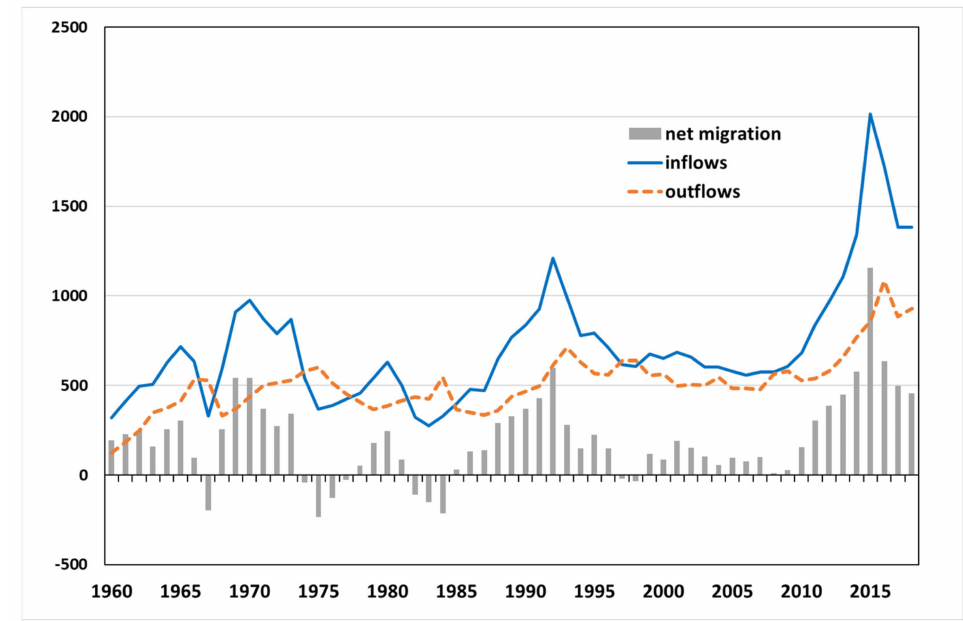
Figure 1. Gross and net migration of non-German migrants (in k), 1954–2018. (Sources: [54]; own design.) Note: Data for the period up until 1990 cover the old territory of the Federal Republic of Germany (including West Berlin); from 1991 onwards, they cover the whole